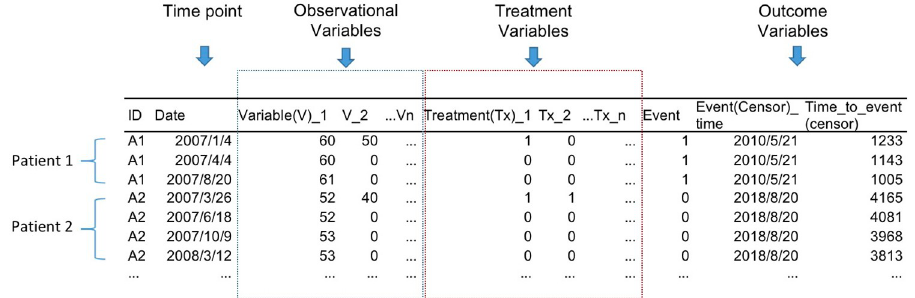
Fig 2. The data structure needed to construct survival path model. The columns includes time points, observational variables, treatment variables (optional) and outcome variables. Each row represent observation data at specific time point, and the date is sorted in ascending order for each